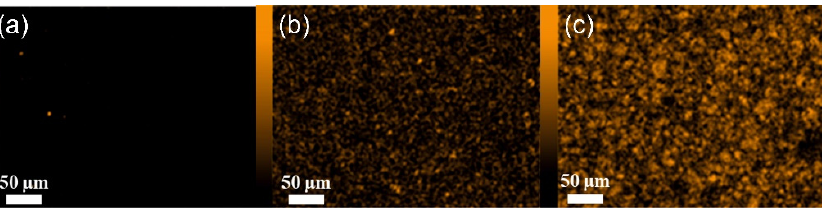
Figure 8. Surface of membranes containing SiO 2 . Mapped Si; ( a ) PEBAX 2533 + 2 wt% SiO 2 , ( b ) PEBAX 2533 + 5 wt% SiO 2 , ( c ) PEBAX 2533 + 10 wt% SiO 2 .